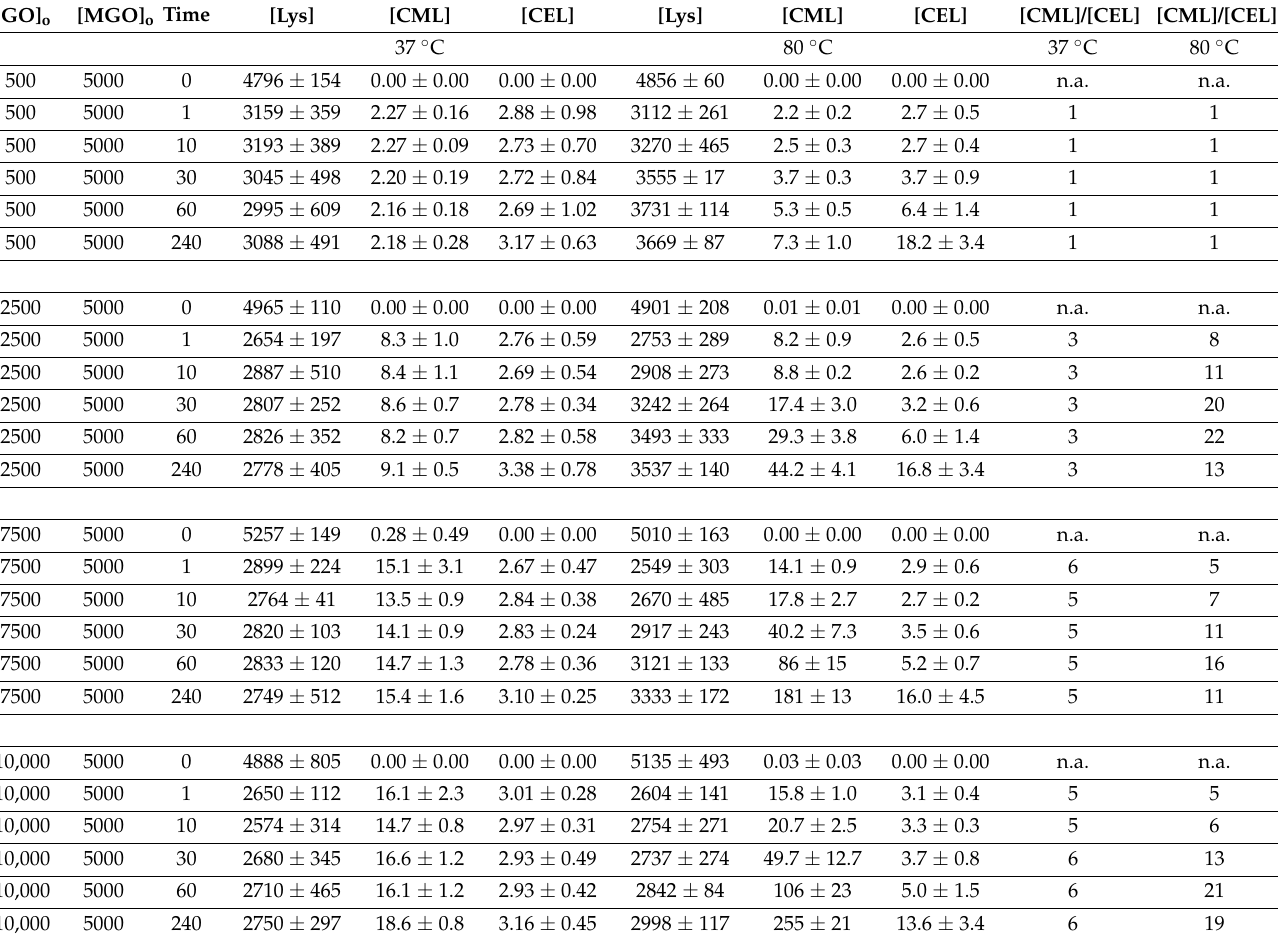
Table 7. Concentration (mean ± SD; µ M) of remaining Lys and formed CML and CEL from the reaction of Lys (5000 µ M) with GO (500, 2500, 7500, 10,000 µ M) and MGO (10,000 µ M), respectively, at 37 ◦ C and at 80 ◦ C for the indicated times (min) in 100 mM phosphate buffer (pH 7.4), and molar ratios of CML and CEL. n.a., not